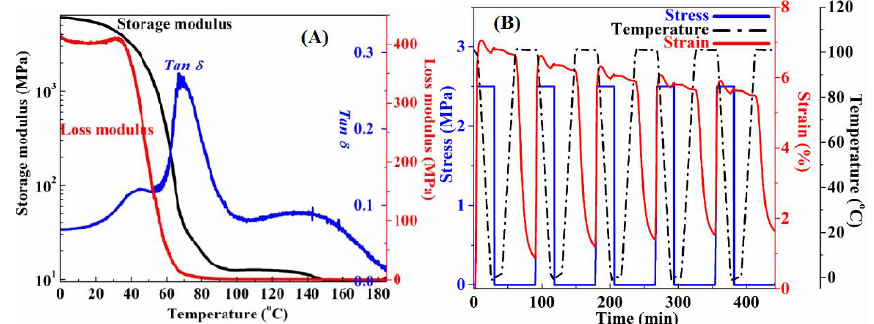
Figure 1. ( A ) Dynamic mechanical analysis (DMA) curves of the polyvinyl alcohol-shape memory polymers (PVA-SMP) sample, including Storage and Loss modulus as a function of temperature, and Tan δ as a function of temperature. ( B ) Stress-controlled cyclic thermo-mechanical testing curves of the PVA based shape memory polymer